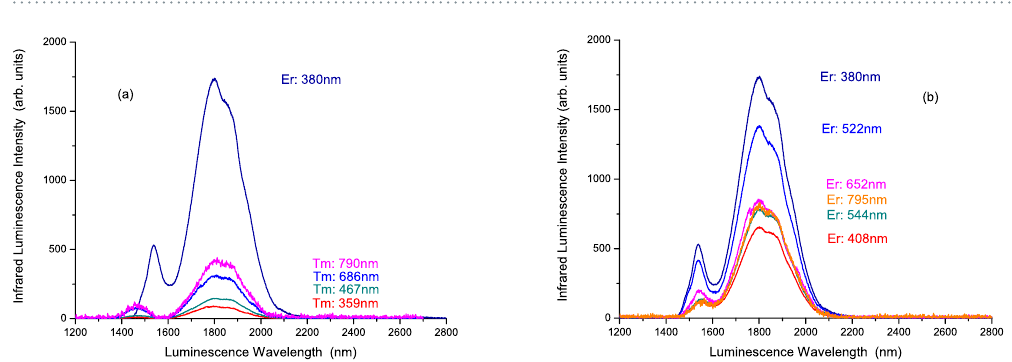
Figure 5. ( a ) Infrared luminescence spectra for sample (A) Er 3 + (8%)Tm 3 + (0.5%):telluride glass when excited by 380 nm, 358 nm, 467 nm, 686 nm, and 790 nm light for the 4 I 15/2 → 4 G 11/2 absorption of the Er 3 + ions, 3 H 6 → 1 D 2 , 3 H 3 H 3 H 3 + ions. ( b ) Infrared luminescence spectra for sample (A) → 1 G → 3 F → 3 H 6 4 , 6 3 , and 6 4 absorption of Tm Er 3 + (8%)Tm 3 + (0.5%):telluride glass when excited by 380 nm, 408 nm, 522 nm, 544 nm, 652 nm, and 795 nm light for the 4 I 15/2 → 4 G 11/2 , 4 I 15/2 → 2 H 9/2 , 4 I 15/2 → 2 H 11/2 , 4 I 15/2 → 4 S 3/2 , 4 I 15/2 → 4 F 9/2 , 4 I 15/2 → 4 I 9/2 absorption of the Er 3 +